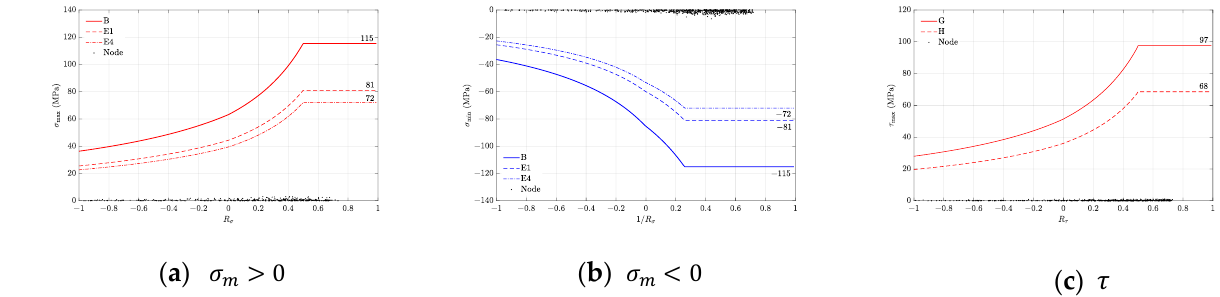
Figure 8. MKJ fatigue characteristic curve at weld position 2 in the driver’s cab.